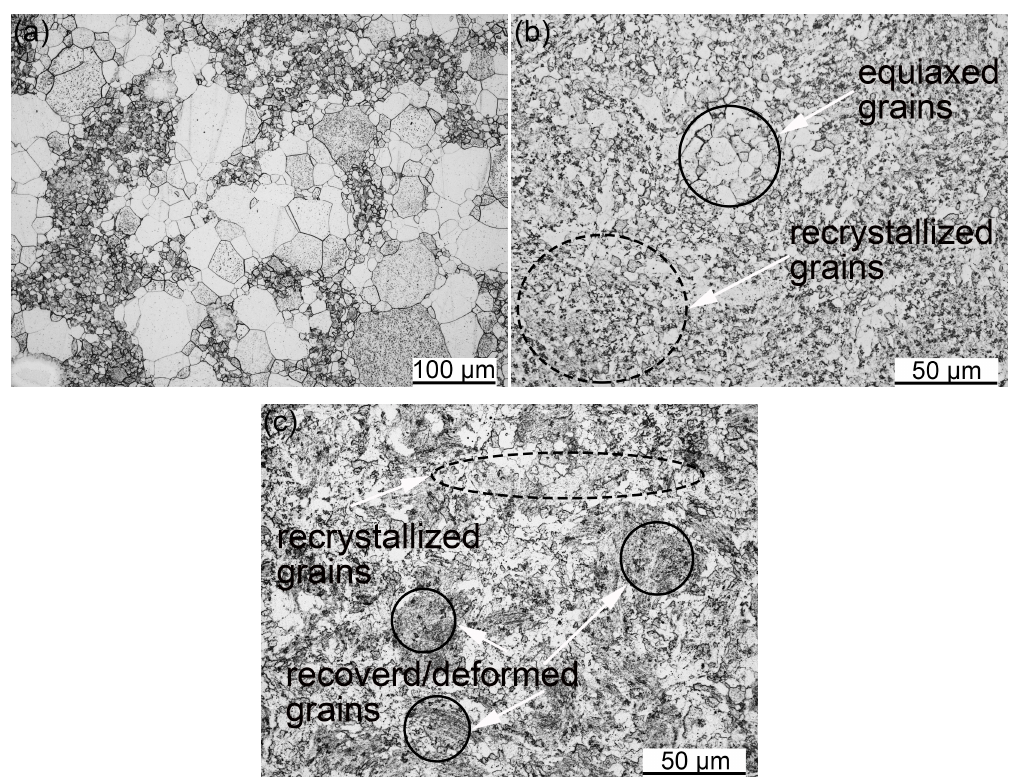
Figure 5. OM images of polished and etched samples: ( a ) MP; ( b ) MX; ( c ) ODS.